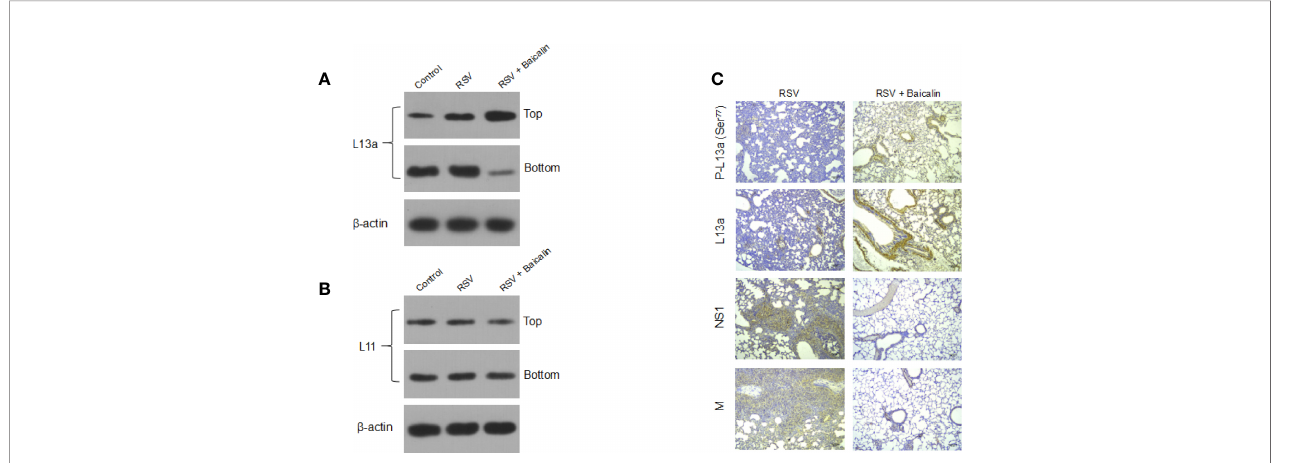
FIGURE 6 | Baicalin represses the translation of RSV M RNA by inducing the extra ribosomal release of the cognate repressor protein L13a. (A, B) Baicalin induced an increase in the release of L13a from ribosomes in mice RSV-infected lungs, as demonstrated by immunoblotting (A) . This release was speci fi c for L13a, as no effect was seen on another larger subunit protein L11 (B) . Top and bottom refer to the released proteins and ribosome sediments, respectively, collected post-sucrose gradient centrifugation using the lung homogenates. Representative blots for one mouse in each group (n = 3) are shown. (C) Immunohistochemistry analysis of L13a, phosphorylated L13a, and RSV viral NS1 and M proteins in lung tissues of RSV-infected mice ± baicalin. Scale bar = 80